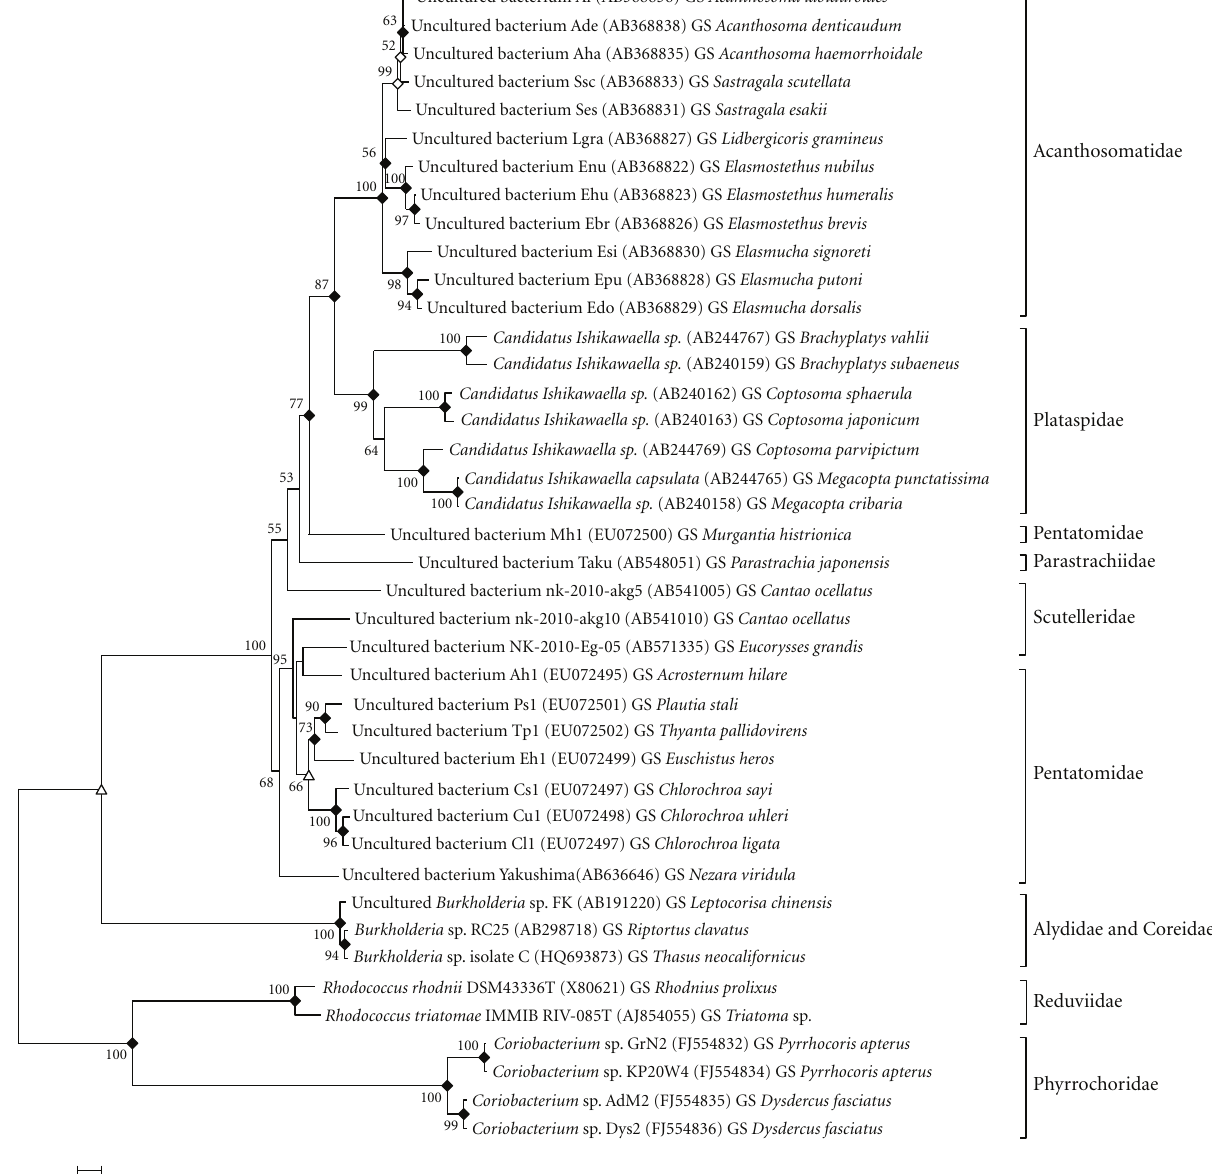
Figure 1: Neighbor-joining tree based on nearly complete 16S rRNA gene sequences (1,300 bp) showing phylogenetic relationships between gut symbionts (GS) of heteropteran species. Insect families are indicated after brackets. Black diamonds indicate branches of the tree that were also recovered with the maximum-likelihood and maximum-parsimony tree-making algorithms; white triangle and diamonds stand for branches that were recovered by the maximum-likelihood or by the maximum-parsimony tree-making algorithms, respectively. Numbers at the nodes are percentage bootstrap values based on a neighbor-joining analysis of 1,000 resampled datasets; only values above 50% are given. Bar 0.01 substitutions per nucleotide